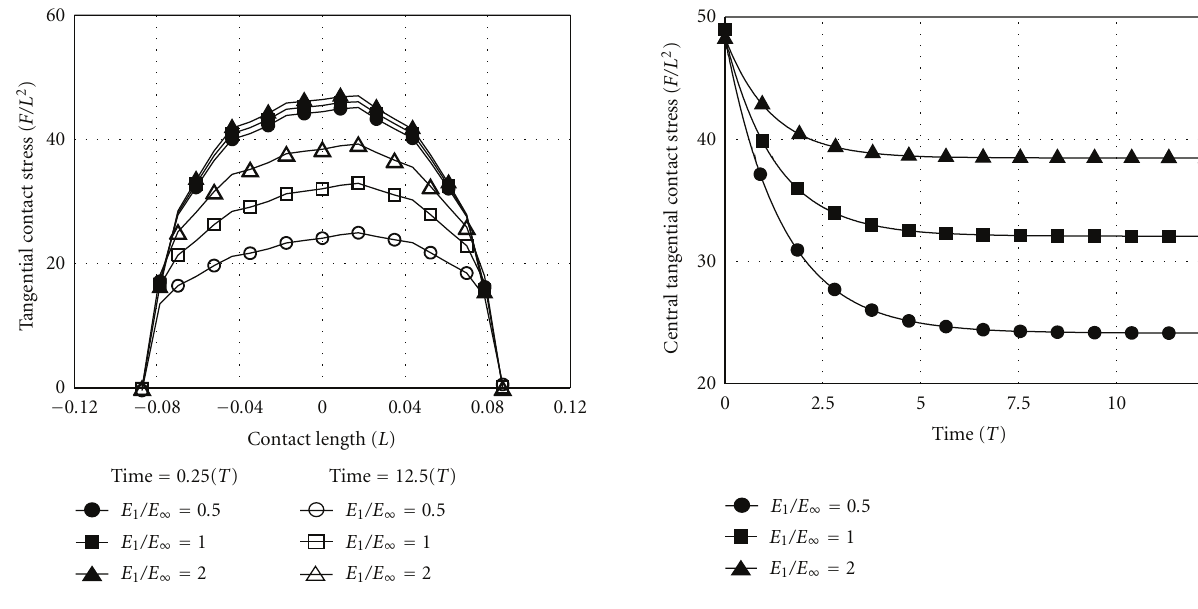
Figure 11: E ff ect of E 1 /E ∞ of on the tangential contact stress distribution.